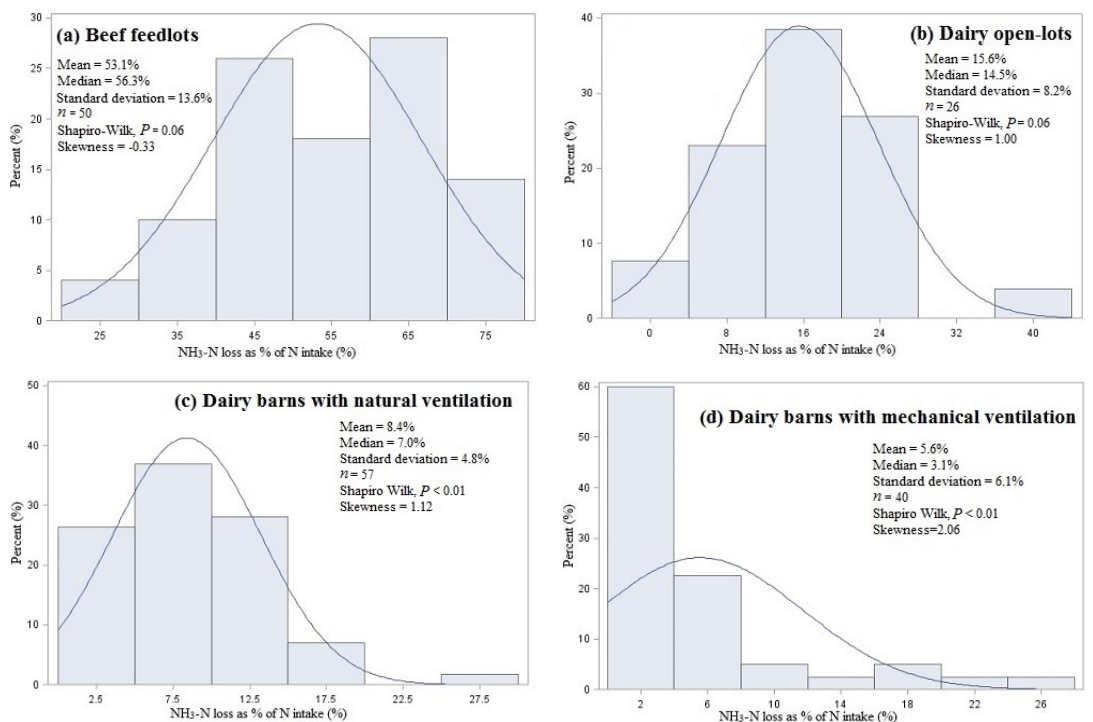
Figure 2. Histograms of NH 3 ‐ N loss as a percentage of N intake for: ( a ) beef feedlots; ( b ) dairy open ‐ lots; ( c ) dairy barns with natural ventilation; and ( d ) dairy barns with mechanical ventilation.